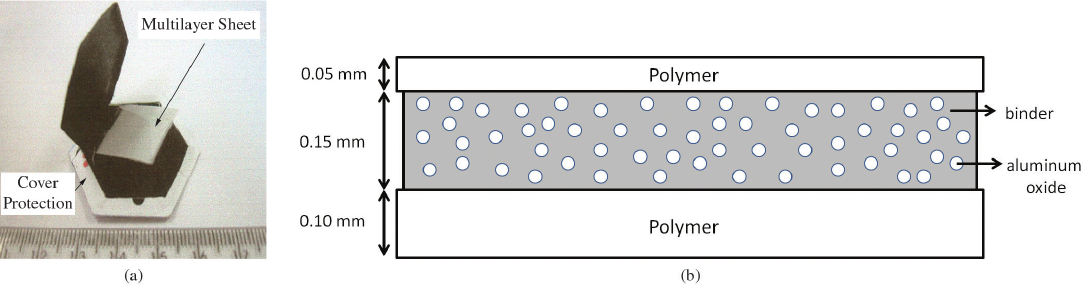
Figure 1. (a) Luxel TM dosemeter and (b) schematic representation of multilayer